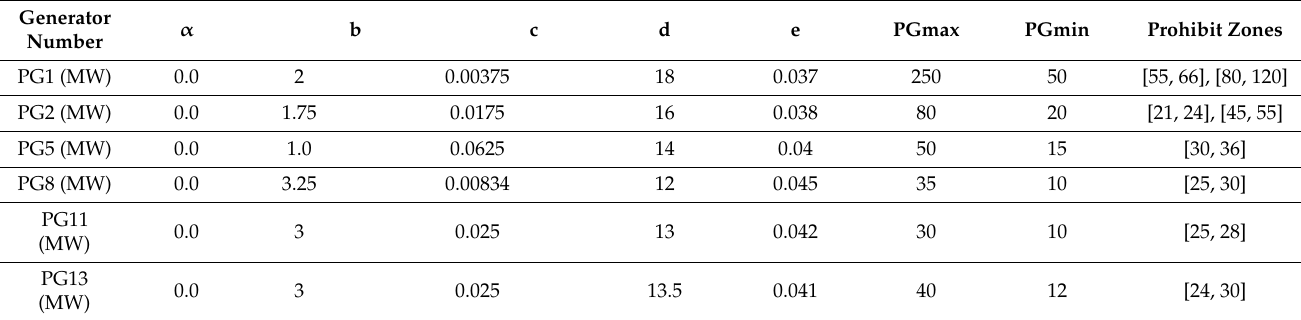
Table A1. Generator cost coefficients and zones for OPF